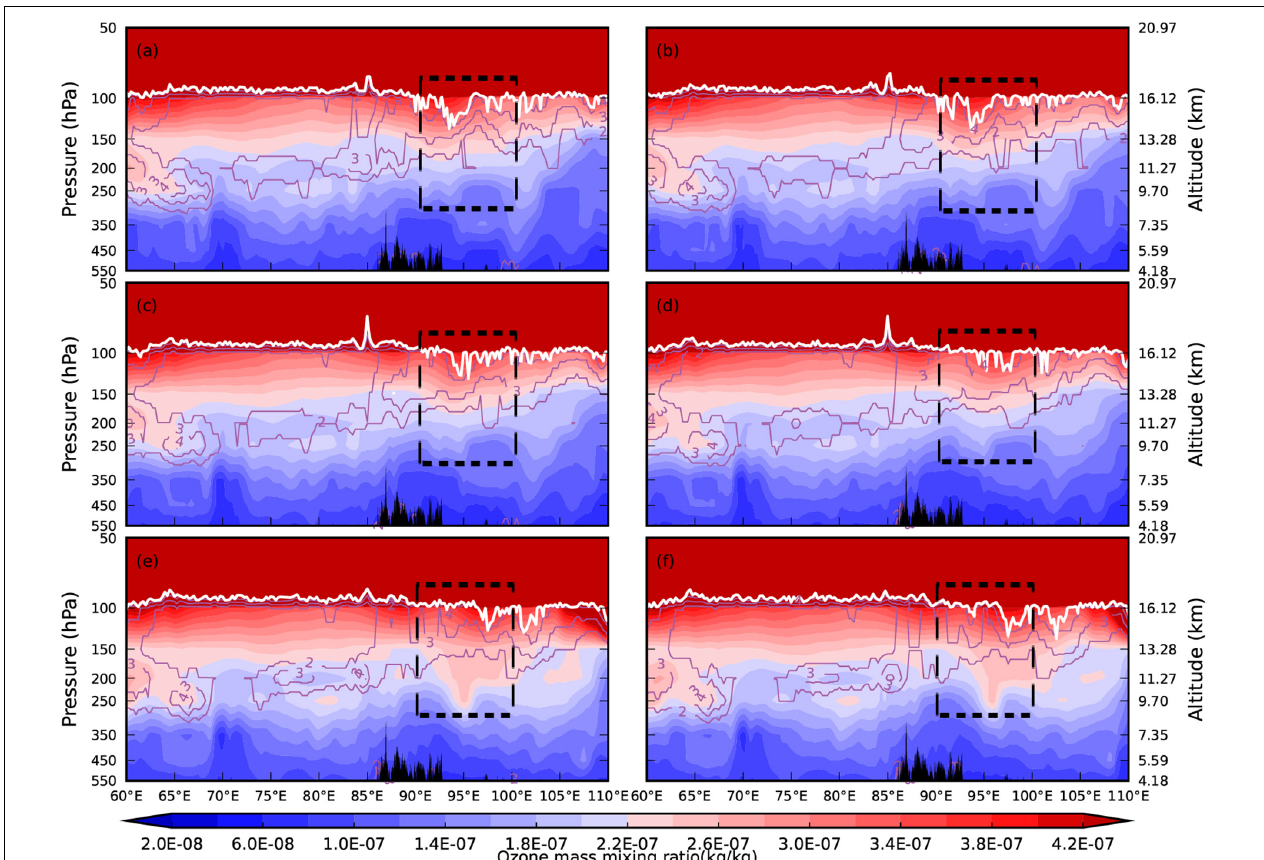
FIGURE 6 | Longitude–height cross section of the ozone mixing ratio ( unit: kg/kg) along 28 ◦ N from ERA5 reanalysis data on 3 May, 2014. The solid white lines indicate the thermal tropopause and the solid purple lines indicate potential vorticity (unit: PVU). Times shown are (a) 18:00; (b) 19:00; (c) 20:00; (d) 21:00; (e) 22:00; and (f)